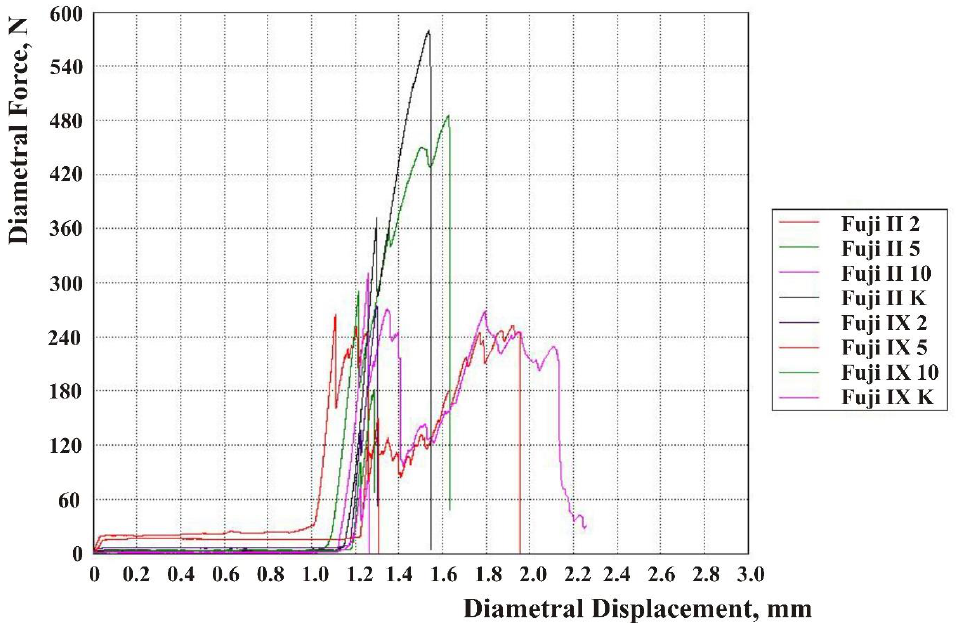
Figure 3. Diametral tensile force-displacement diagram for the Fuji IX and Fuji II groups.